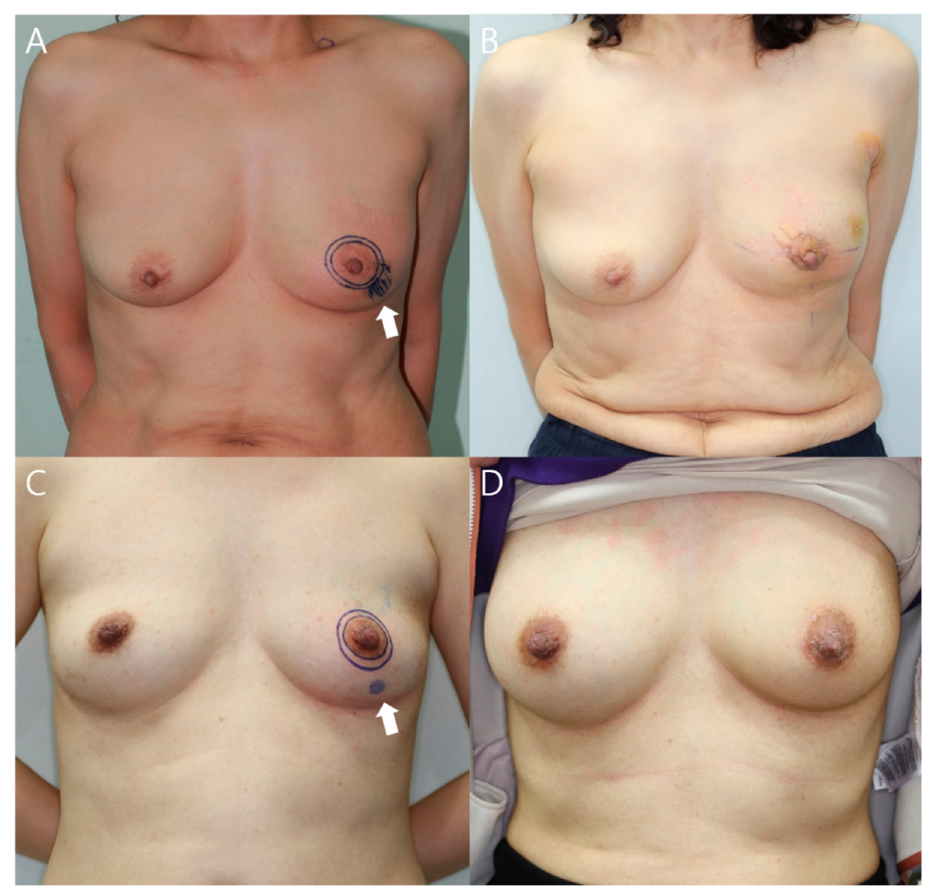
Figure 6. Preoperative ( left ) and postoperative ( right ) 12-month photographs of patients with cancer located in the lower outer quadrant of the left breast. White arrow indicates tumor location. ( A ) This 53-year-old patient underwent breast reconstruction with RBT alone after breast-conserving surgery and the resected breast tissue was 13 g; ( B ) Depression deformity was noted 12 months after surgery; ( C ) This 41-year-old patient underwent breast reconstruction using the one ADM with the RBT after breast-conserving surgery and the resected breast tissue was 12 g; ( D ) There were no cosmetic problems after 12 months of